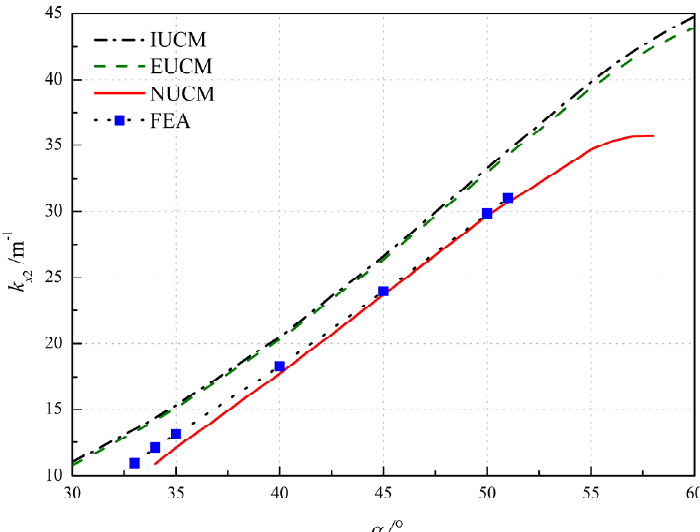
Figure 5. Variation of the principal curvature with respect to the angle of layup α .